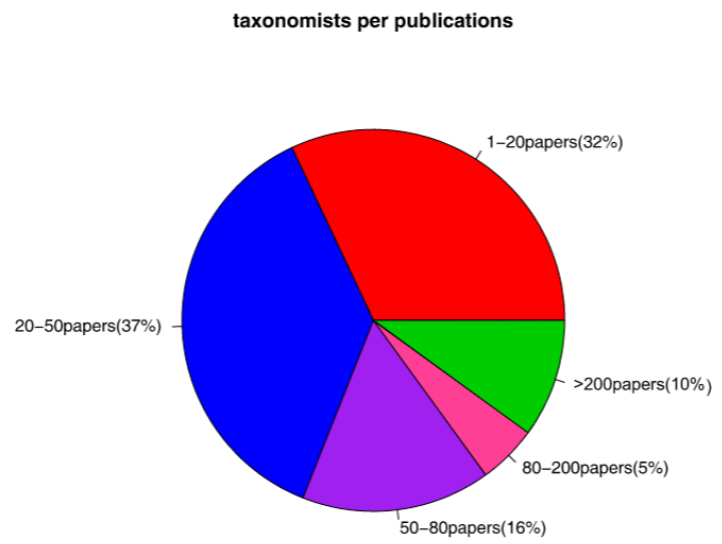
Figure 3. Distribution of taxonomists according to taxonomic papers published.